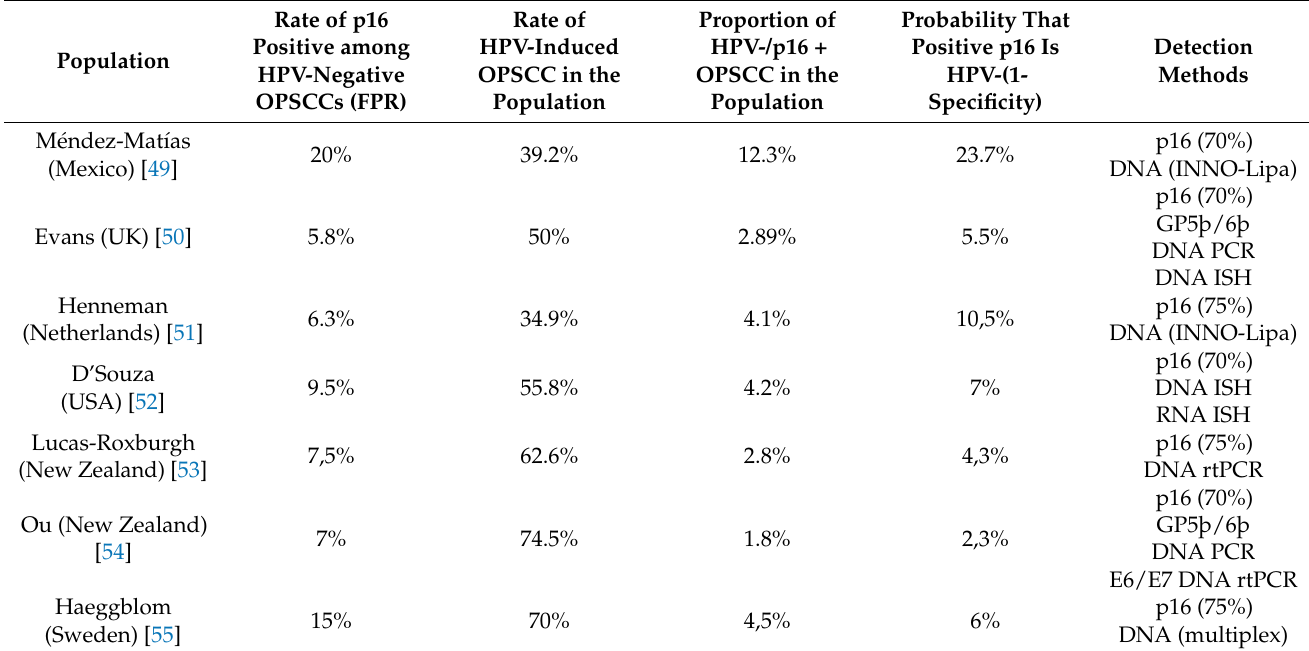
Table 2. Prediction of the rate of false positive tests (1-specificity) at p16 IHC when the reference is the combination of p16IHC + genomic DNA PCR, according to the proportion of HPV-driven OP- SCCs in a given population. The calculation is made by the formula in Figure 1.